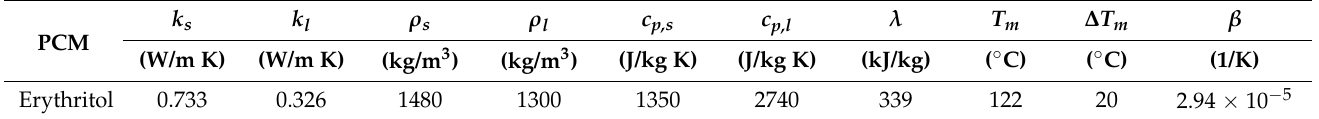
Table 1. PCM thermophysical properties.